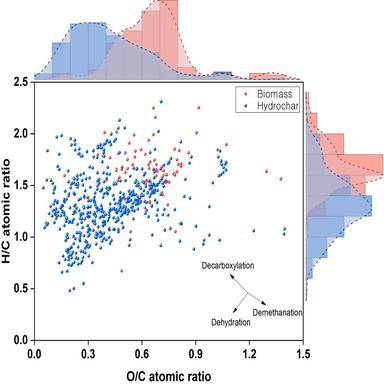
van Krevelen diagram in transforming biomass to hydrochar during the HTC process.